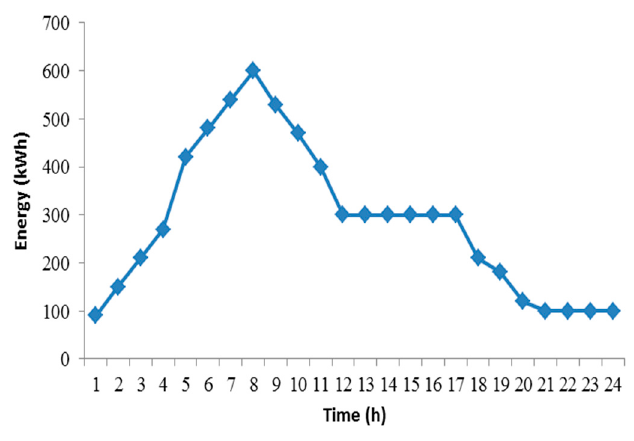
Figure 6. Residual energy of BESS.